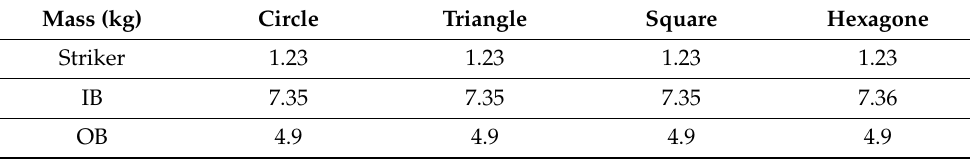
Table 6. Mass of the bars and striker between the different SHPB